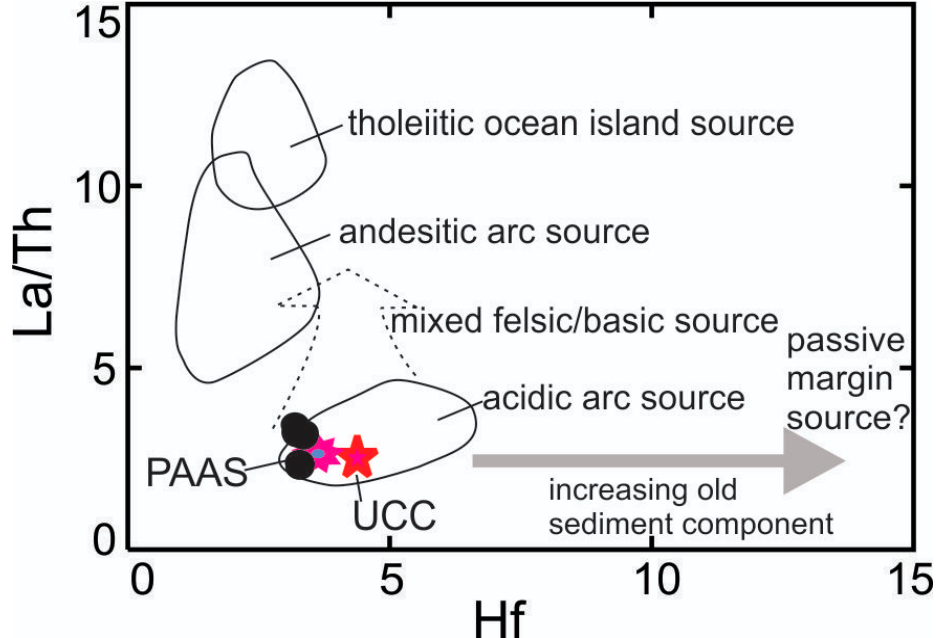
Figure 11. Plot of La/Th ratio versus Hf for the Brahmaputra River sediments. Fields after Floyd and Leveridge [42] and Gu et al. [52]. Brahmaputra River sediment samples are represented by the black dots.